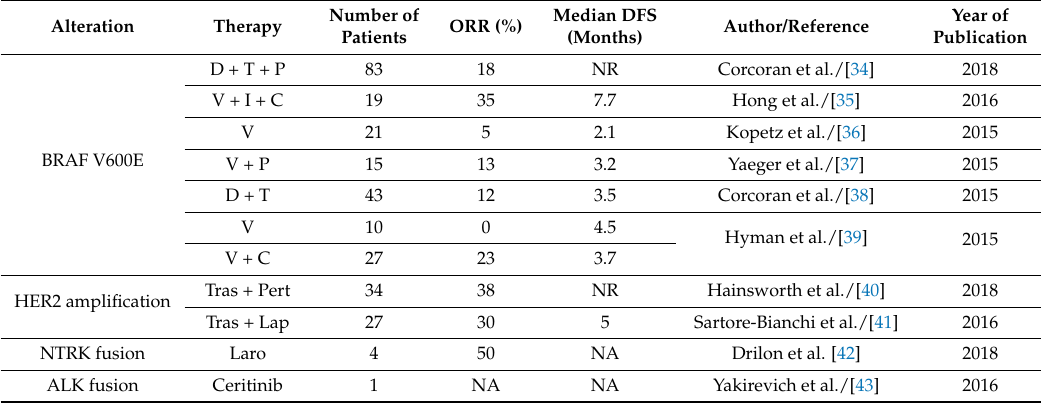
Table 1. Summary of studies investigated the effect of targetable genomic alterations on survival in metastatic